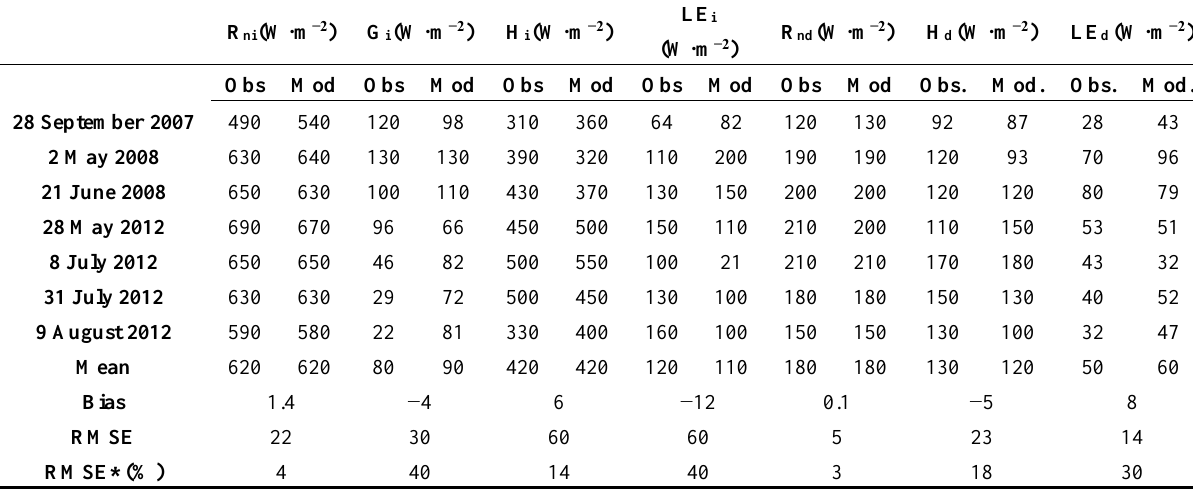
Figure 4. Maps of instantaneous values of ( a ) P ( e ) H (W·m −2 ), and ( f ) LE (W·m −2 ), obtained from the L7-TM image corresponding to the date 1 August 2012. In this figure the SLC gaps have been filled, only for display purposes using the ENVI v4.7 Landsat Gapfill tool with the “single file gap triangulation” method selected. Table 2. Quantitative analysis of the comparison between modeled (Mod.) and observed (Obs.) values of the different surface energy fluxes at the forest and forest_c sites, for years 2007 and 2008 (three dates) and 2012 (four dates),